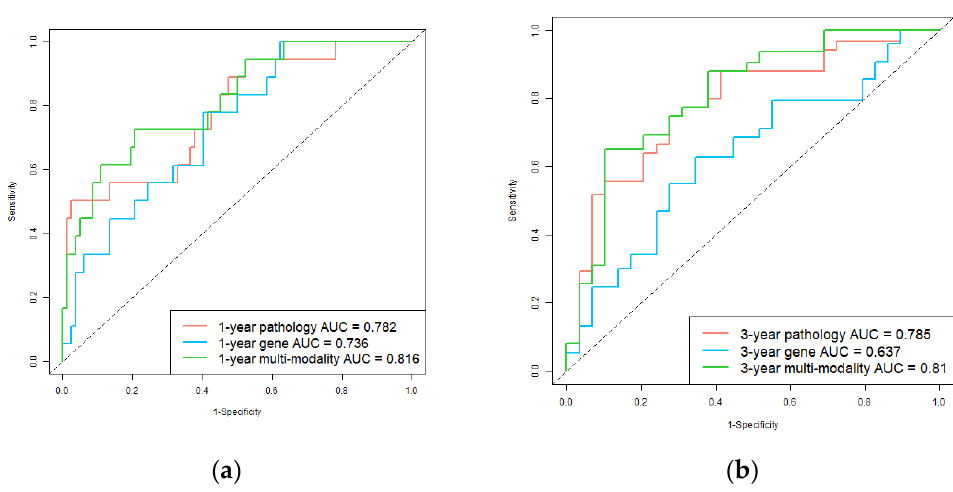
Figure 3. Receiver operating characteristic (ROC) curves of single-modality and multi-modality models in the test set. ( a ) 1-year hepatocellular carcinoma (HCC) overall survival prediction ROC of the models; ( b ) 3-year HCC overall survival prediction ROC of the models. Red, blue, and green plots represent the pathology prediction model, gene prediction model, and multi-modality prediction model, respectively.